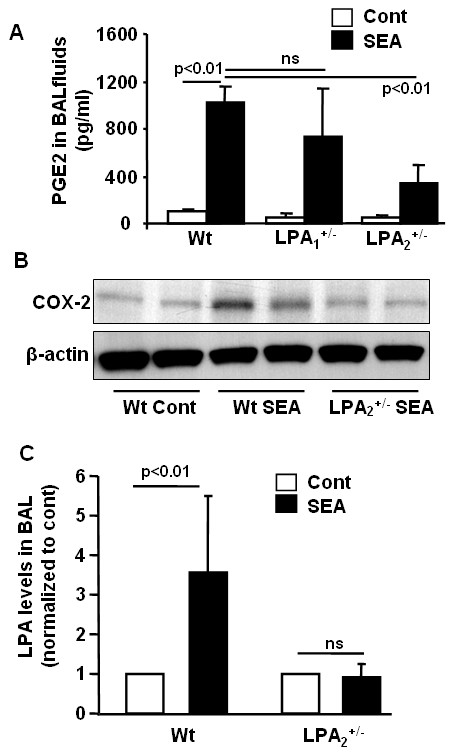
LPA2+/- mice exhibit a decrease in PGE2 and LPA levels in BAL fluids and COX-2 expression in lung tissue. BAL fluids and lung tissue were collected from SEA unchallenged and challenged wild type, LPA1+/-, and LPA2+/- mice (n = 4-6). A) PGE2 levels were measured by ELISA kit. B) Lung tissues were subjected to SDS/PAGE gel and COX-2 expression was determined by Western blotting. Representative image were shown. C) LPA levels in BAL fluids were quantified by LC-MS/MS and changes in LPA levels between wild type and SEA challenge mice were normalized to control levels.